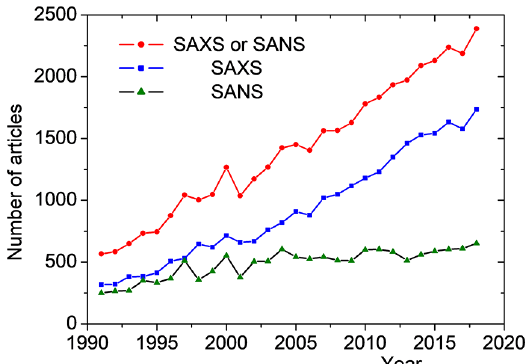
Figure 1. Annual numbers of published articles related to SAXS, SANS and SAS (SAXS or